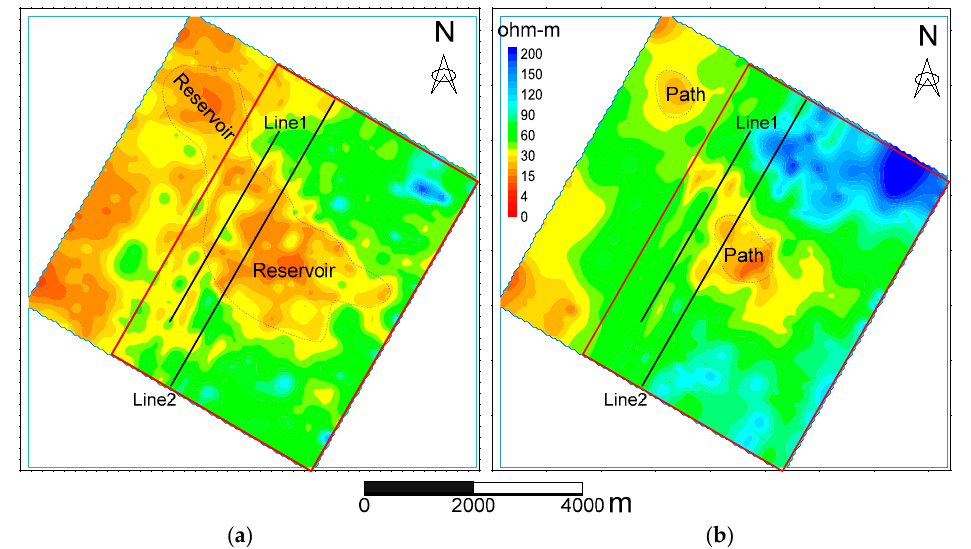
Figure 5. Resistivity contour maps at elevations of ( a ) 3500 m and ( b ) 2000 m ASL. The reservoir and the thermal path of the geothermal system are outlined with the blue dashed line. Line1 and Line2 show the location of the section of Figures 3 and 4. The red rectangle shows the portion where three ‐ dimensional imaging is conducted and shows in Figure 6.